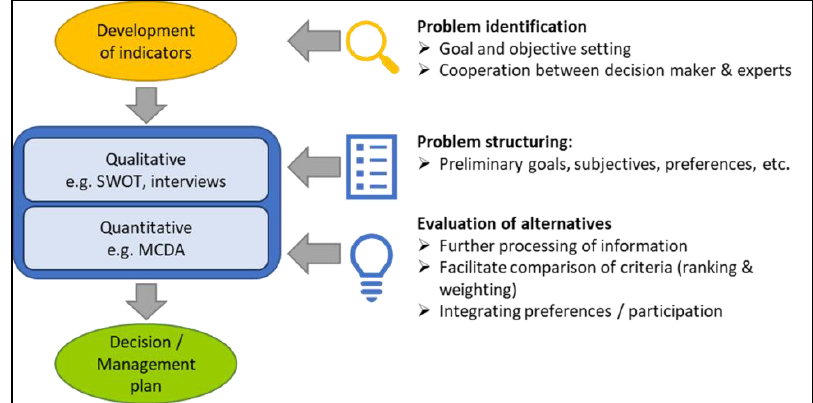
Figure 3. Combining different approaches (e.g., SWOT and multiple-criteria decision analysis, or MCDA) in a planning process [24] (p. 375, with alterations). MCDA) in a planning process [24] (p. 375, with